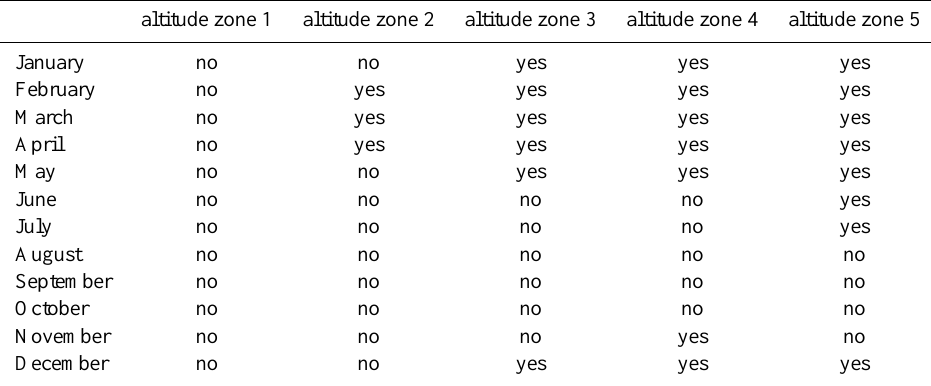
Table 2. The significance of decreasing trends of the simulated SWE in all altitude